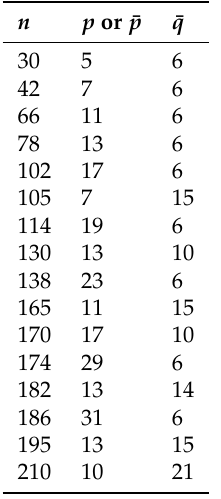
Table 1. Values of n that admit idempotent factorizations. n p or ¯ p ¯